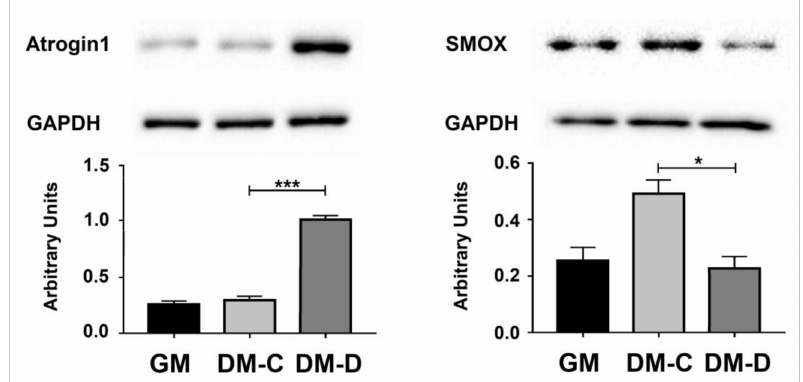
Figure 5. SMOX and Atrogin1 proteins expression profile in atrophic C2C12 cells. Western blot analyses of Atrogin1 (C) and SMOX (E) proteins on murine C2C12 GM, DM-C and DM-D. Data are calculated relative to the internal housekeeping GAPDH gene, used as a loading control. The quantification of total levels of Atrogin1 and SMOX proteins were determined by densitometric analyses and